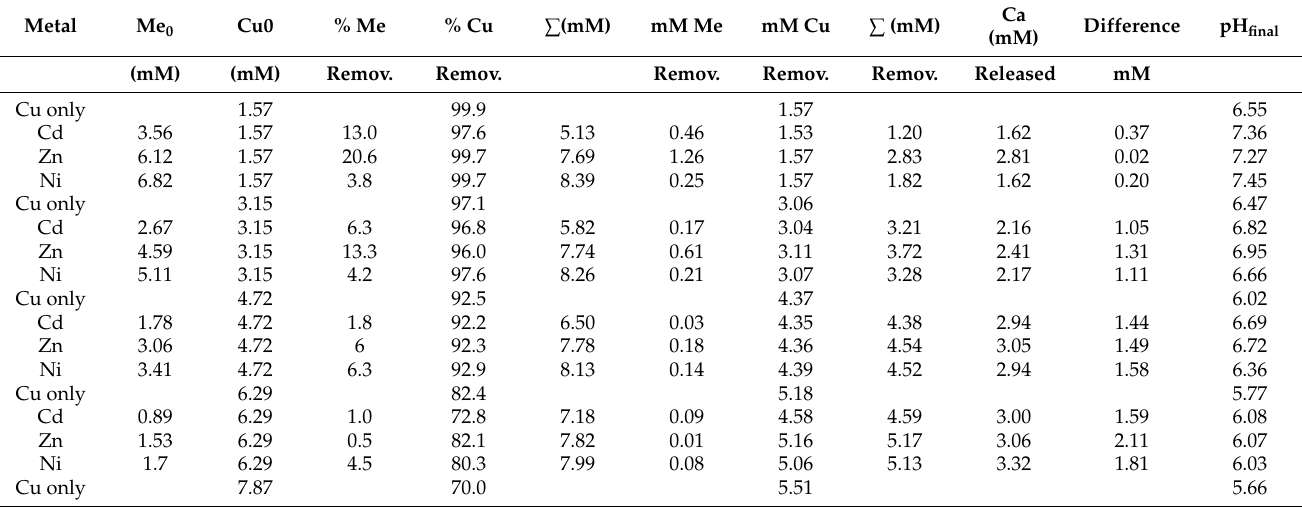
Table 4. Effect of co-ions on the Cu 2+